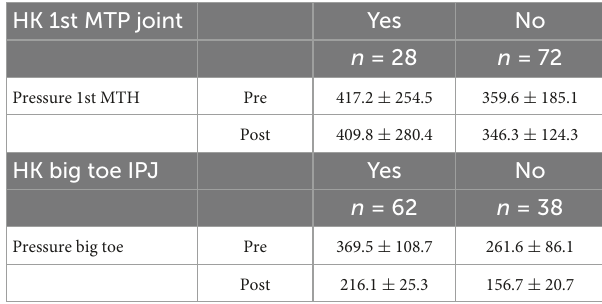
TABLE 3 Mean pressure under the first MTH and big toe, k-means